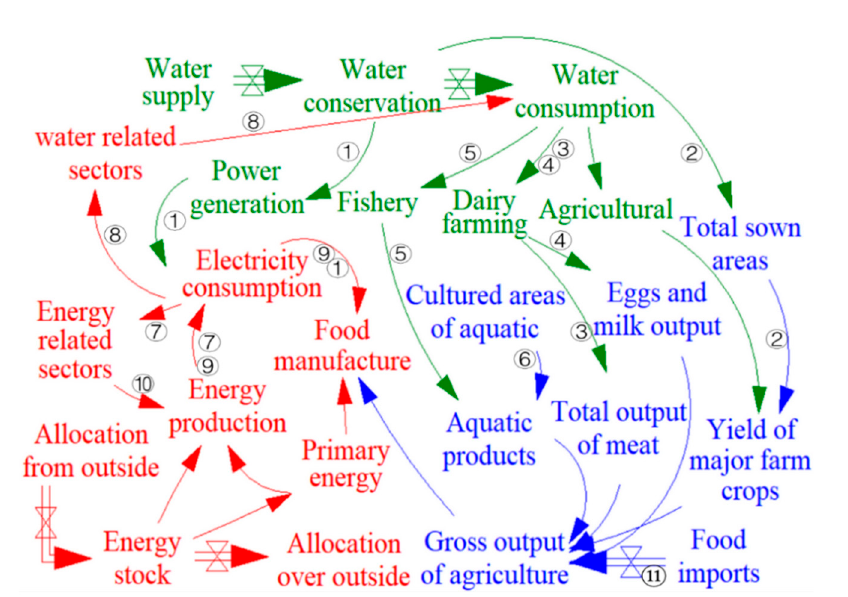
Figure 1. Causal loop diagram within WEF-Nexus order parameters.